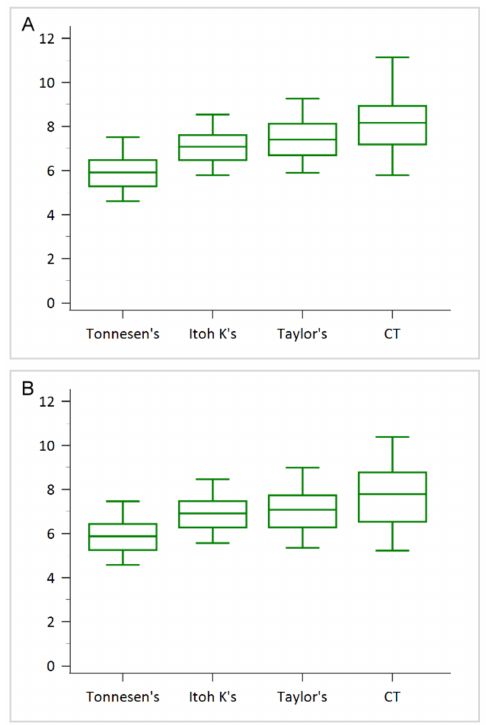
Figure 5. The boxplots for comparison of the bilateral renal depth measured by three formulas (Tonnesen’s, Itoh K’s, and Taylor’s) and the CT scan. ( A ), right renal depth. ( B ), left renal depth.